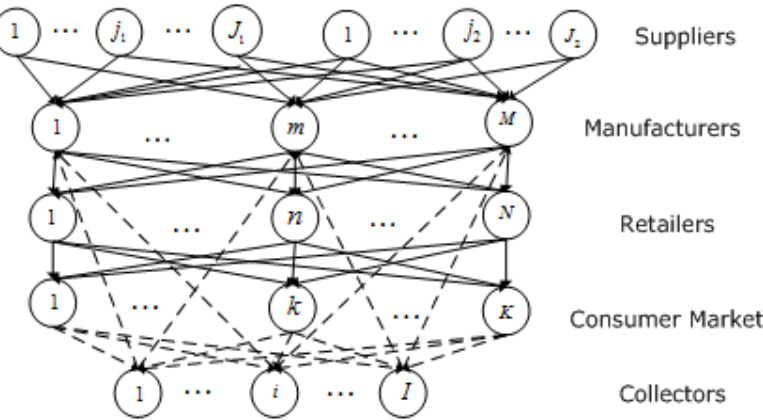
Figure 1. The structure of CLSC network with two-type